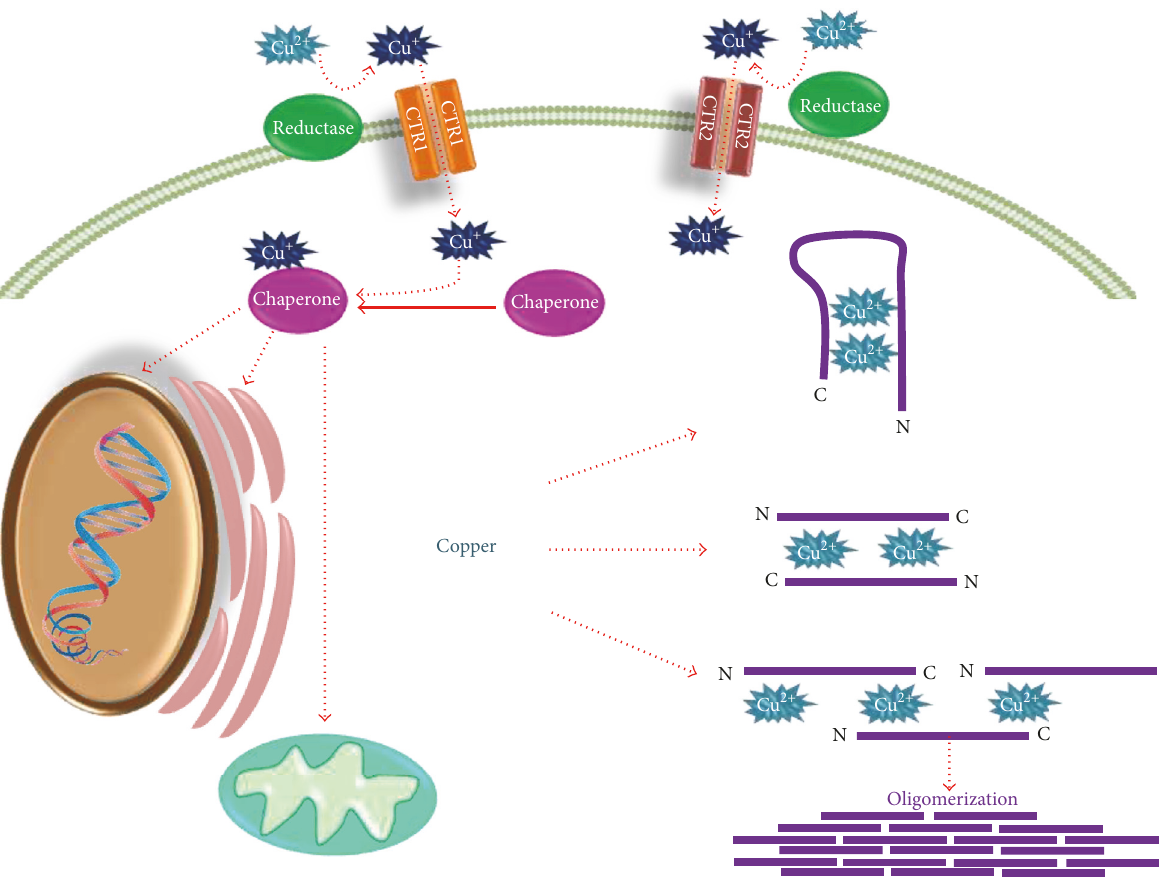
Figure 3: 𝛼 -Synuclein-copper complex formation process . Copper can be found in living organisms in both forms, oxidized Cu 2+ and reduced Cu + , and enters into the cell as Cu + through CTR1 and CTR2. Afterwards, copper is transported to the nuclei, endoplasmic reticulum, and mitochondria via chaperone proteins. An overload of copper may lead to the 𝛼 -synuclein-copper complex formation by three potential mechanisms. In the first one, a single 𝛼 -synuclein molecule binds to Cu 2+ , folding and bringing together the amino and carboxy-terminal ends. The second mechanism involves two molecules of 𝛼 -synuclein with a head-to-tail arrangement, generating a copper-binding site at both ends. In the third mechanism, the carboxy-terminal region of one molecule of 𝛼 -synuclein interacts with the amino-terminal region from another molecule of 𝛼 -synuclein creating a Cu 2+ binding site. Next, one of the two 𝛼 -synucleins interacts with a third 𝛼 -synuclein molecule, forming a second Cu 2+ binding site. This process will eventually lead to 𝛼 -synuclein oligomerization.